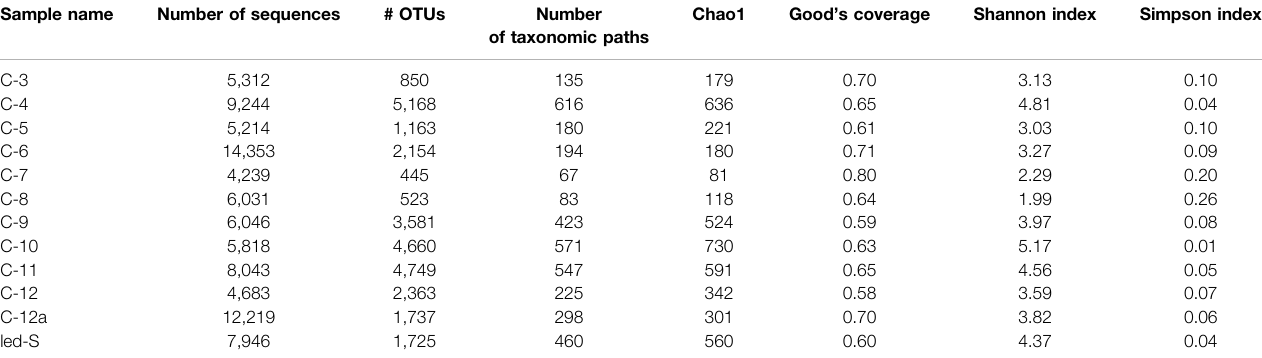
TABLE 2 | Characteristics of the amplicon libraries of the Mamontova Gora and